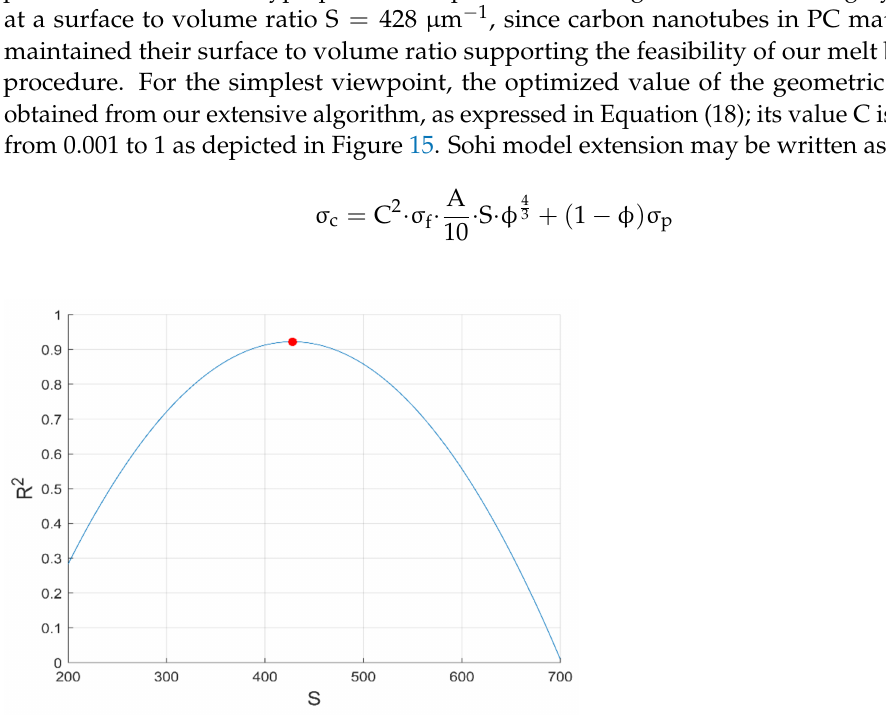
Figure 14. Optimization of surface-to-volume ratio of CNT nanofiller for the Sohi extension